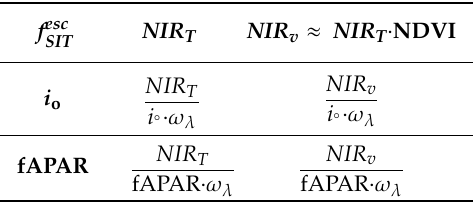
Table 1. Four estimation formulas for Solar-induced chlorophyll fluorescence (SIF) escape probabilities based on spectral invariants theory (SIT) ( f esc SIT